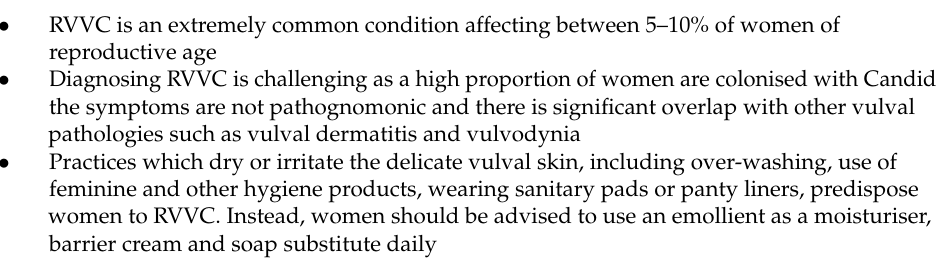
Table 1. What is known about recurrent vulvovaginal candidiasis